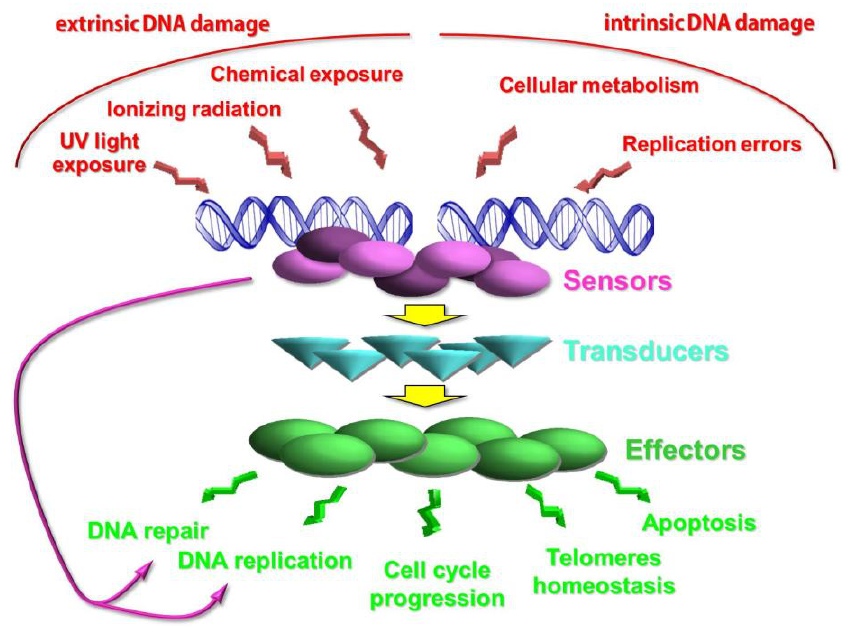
Figure 1. Schematic representation of the DNA damage